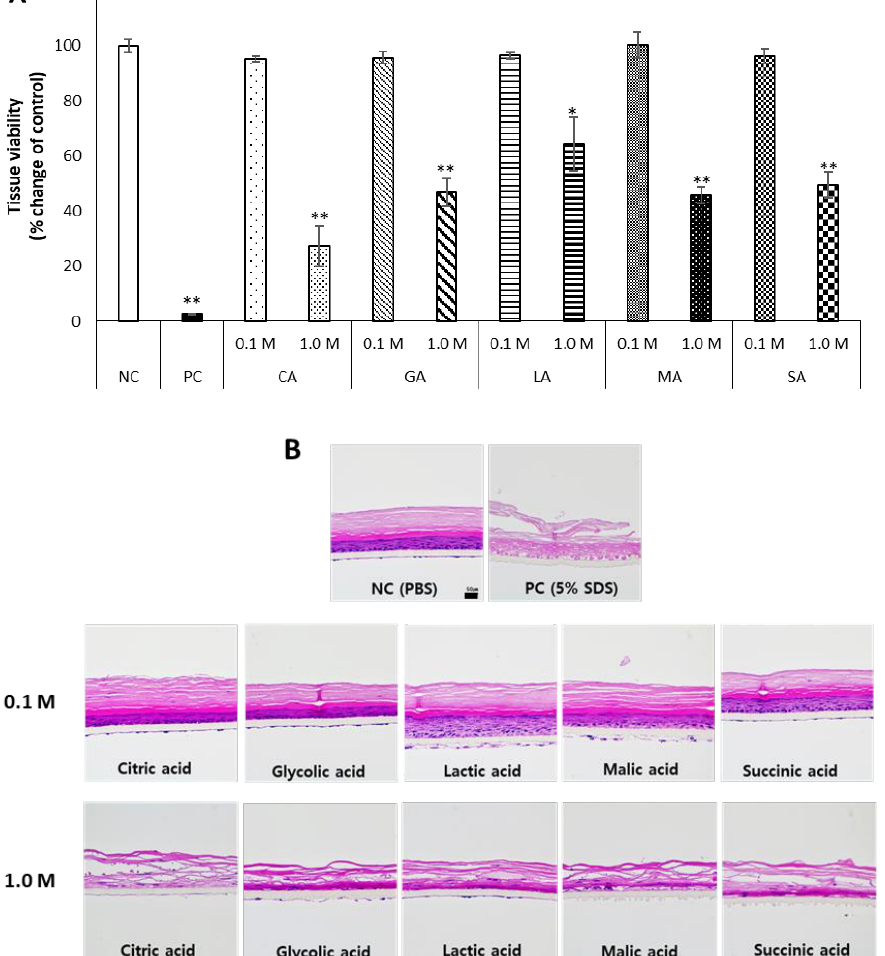
Figure 2. Various organic acids were prepared at a low concentration (0.1 M) and a high concentration (1.0 M) and exposed to KeraSkin™ for 30 min. Then, ( A ) cell viability was evaluated, and ( B ) skin tissues were stained with H&E. Scale bar is 50 μm. NC; negative control (DW) with white bars, PC; positive control (5% SDS) with filled bars. Tested samples with patterned bars, CA; citric acid, GA; glycolic acid, LA; lactic acid, MA; malic acid, SA; succinic acid. * p < 0.05, ** p < 0.01. KeraSkin™ tissues remaining after the MTT assay were processed and stained with H&E. When treated with low concentrations of organic acids, the stratified structures of the stratum corneum, stratum granulosum, stratum spinosum, and stratum basale were relatively well preserved, similarly to the negative control. However, when